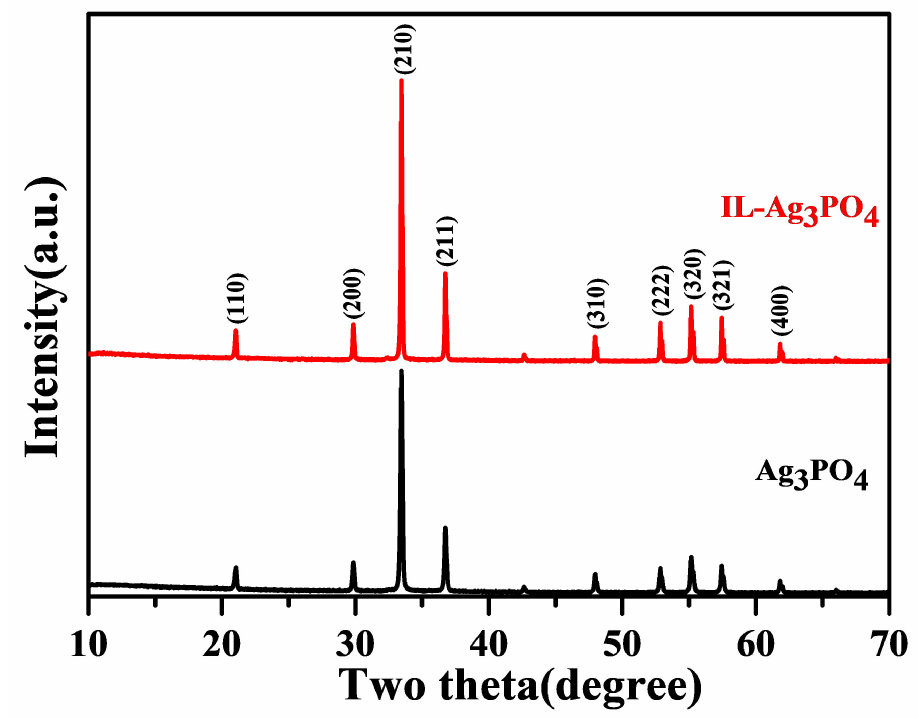
Figure 1. XRD patterns of Ag 3 PO 4 and IL-Ag 3 PO 4